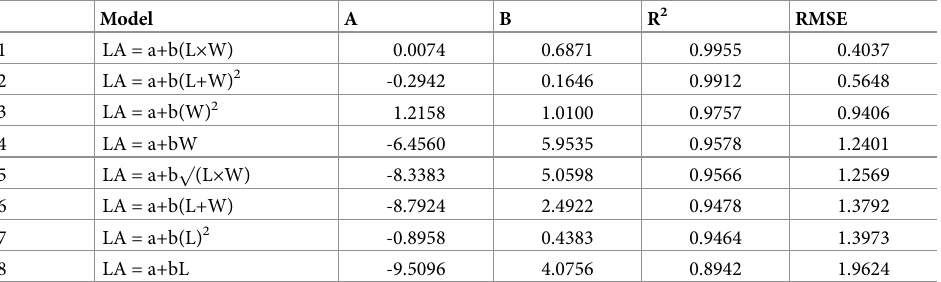
Table 3. Fitted models to estimate the LA from leaf length (L) and leaf width (W) in plum ( prunus vachuschtii , Alucheh Gavali) in 2019.